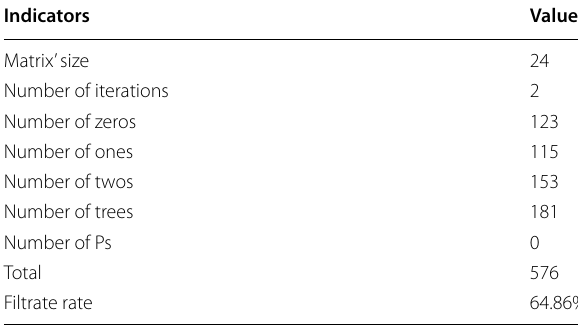
Table 2 Matrix of direct influence